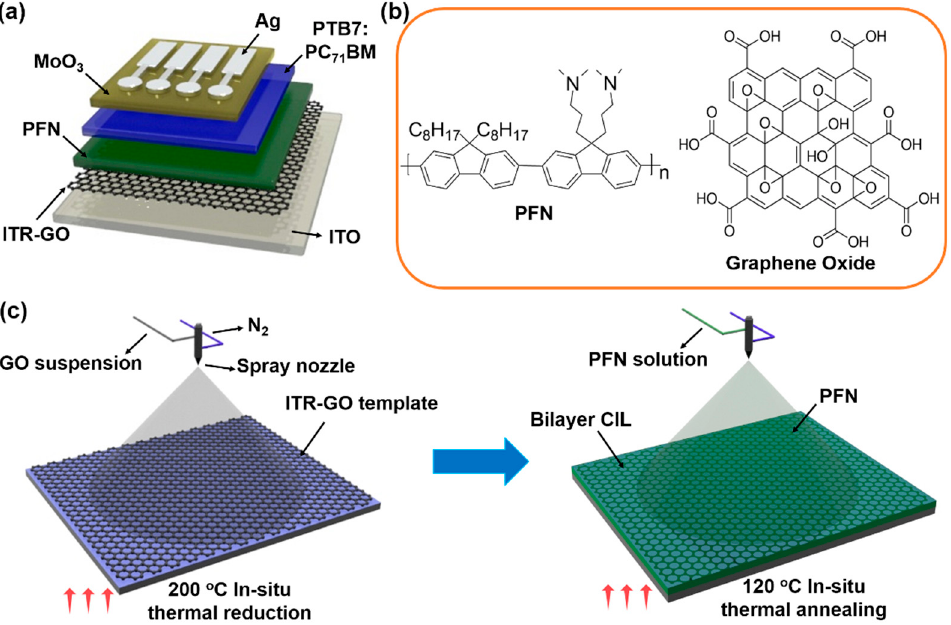
Figure 1. ( a ) Device architecture of organic solar cells (OSCs), ( b ) chemical structures of materials, and ( c ) schematic of fabrication process of bilayer cathode interlayer (CIL).